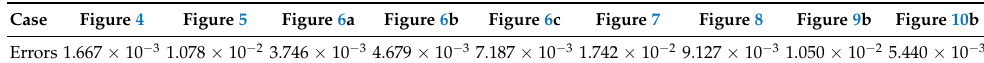
Table 2. Accurate evaluation of our